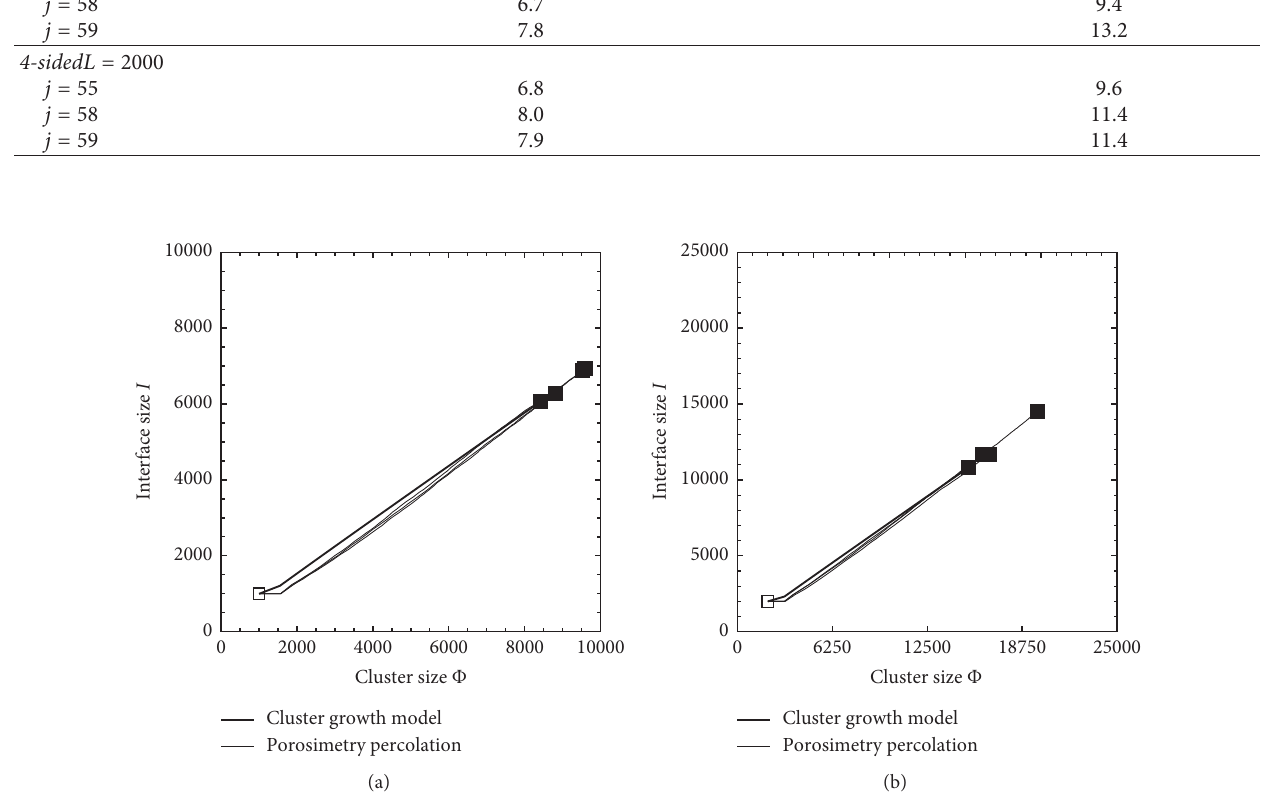
� 1996, I � 1988), (d) 0 0